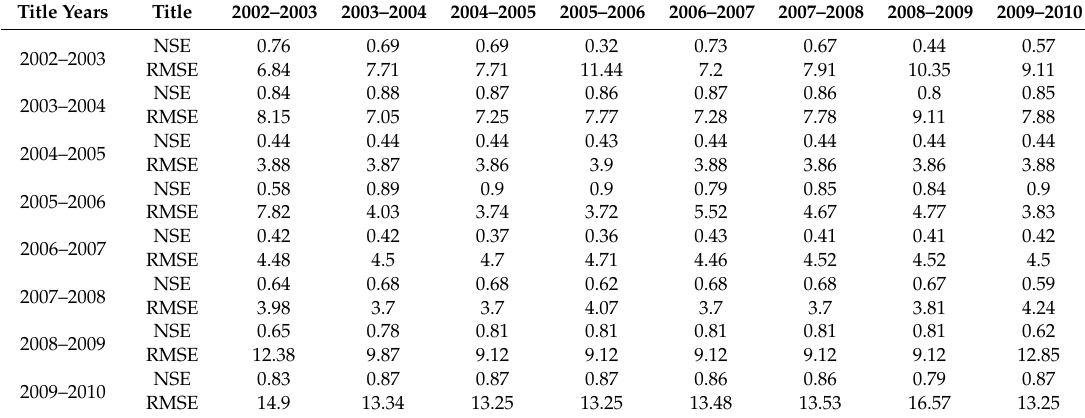
Table 3. Maximum NSE and minimum Root Mean Square Error (RMSE) obtained after validation (calibration years in columns and validation years in